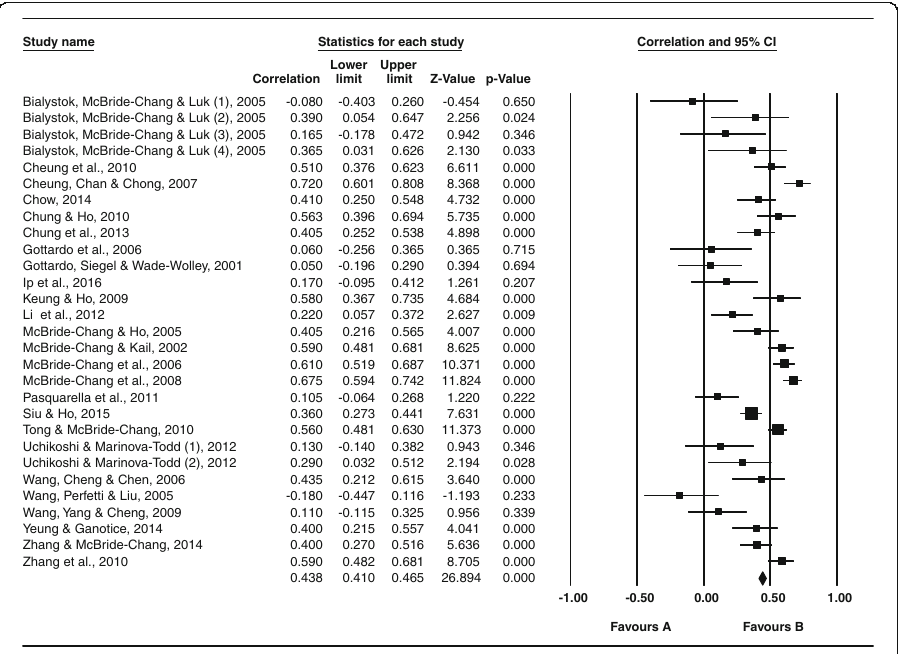
Fig. 4 Overall average correlation and correlation with confidence interval for each study correlating Chinese and English decoding. Note. Overall correlation shows at the bottom of the figure. Diamond shape = overall correlation average across listed studies on graph. Size of square reflects sample size, with bigger square representing a larger sample size (Bialystok, McBride-Chang & Luk 2005; Cheung et al., 2007; Cheung et al., 2010; Cheung, Chan & Chong, 2007; Chow 2014; Chung & Ho 2010; Chung et al., 2013; Gottardo et al., 2006;